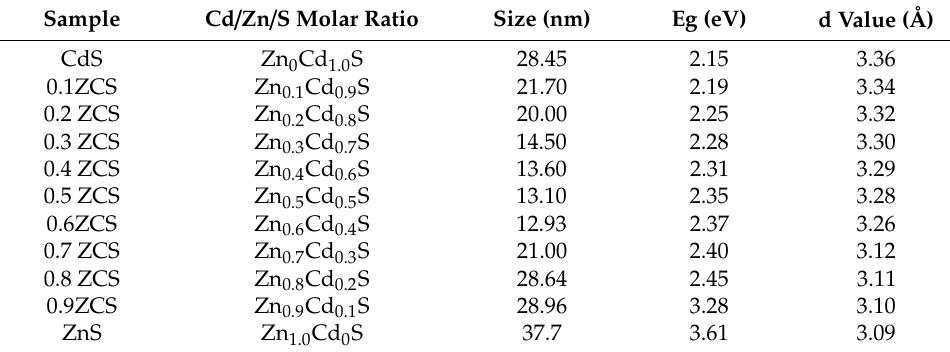
Table 1. Elemental composition and characterization results of the prepared samples.